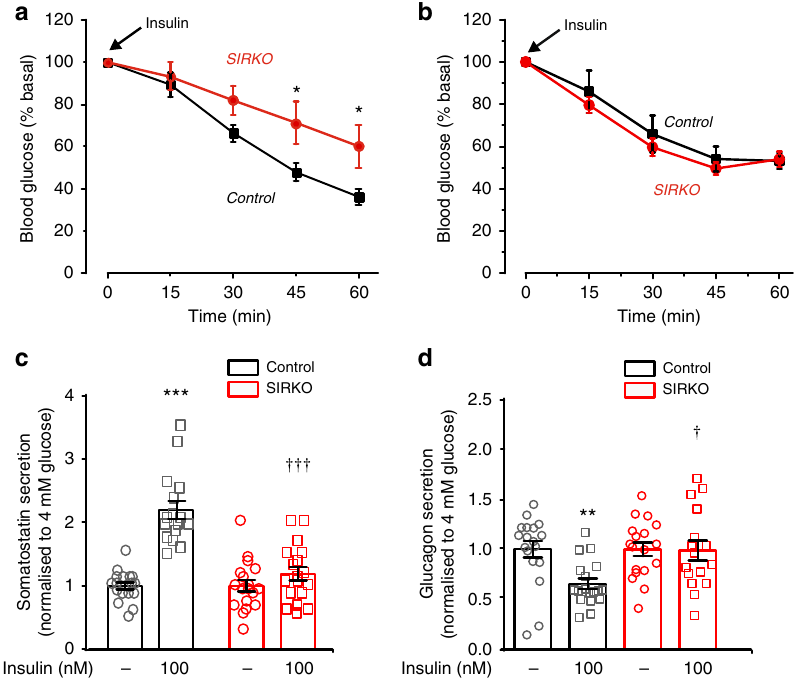
Fig. 3 Insulin ’ s glucagonostatic effect mediated by InsR in δ cells. a , b Insulin tolerance test. Plasma glucose concentrations following injection of insulin (at t = 0; 1.5 U/kg) in female ( a ) and male ( b ) controls (black; n = 10 female and 6 male mice) and δ -cell-speci fi c insulin receptor knockout (SIRKO, red; n = 9 female and 6 male mice) mice. * p < 0.05 vs control, two-way ANOVA followed by Sidak ’ s post hoc test. c , d Somatostatin ( c ) and glucagon secretion ( d ) at 4 mM glucose in the absence or presence of insulin (100 nM) in islets from control (black; n = 20/4 mice) or SIRKO (red: n = 18 with insulin and 20 without insulin/4 mice) mice. Responses have been normalised to secretion at 4 mM glucose. ** p < 0.01, *** p < 0.001 vs 4 mM glucose; † p < 0.05 and ††† p < 0.001 vs 4 mM glucose and 100 nM insulin in control islets, two-way ANOVA followed by Sidak ’ s post hoc test. Data are presented as dot plots of individual experiments and/or mean values± S.E.M. of all experiments with the experimental